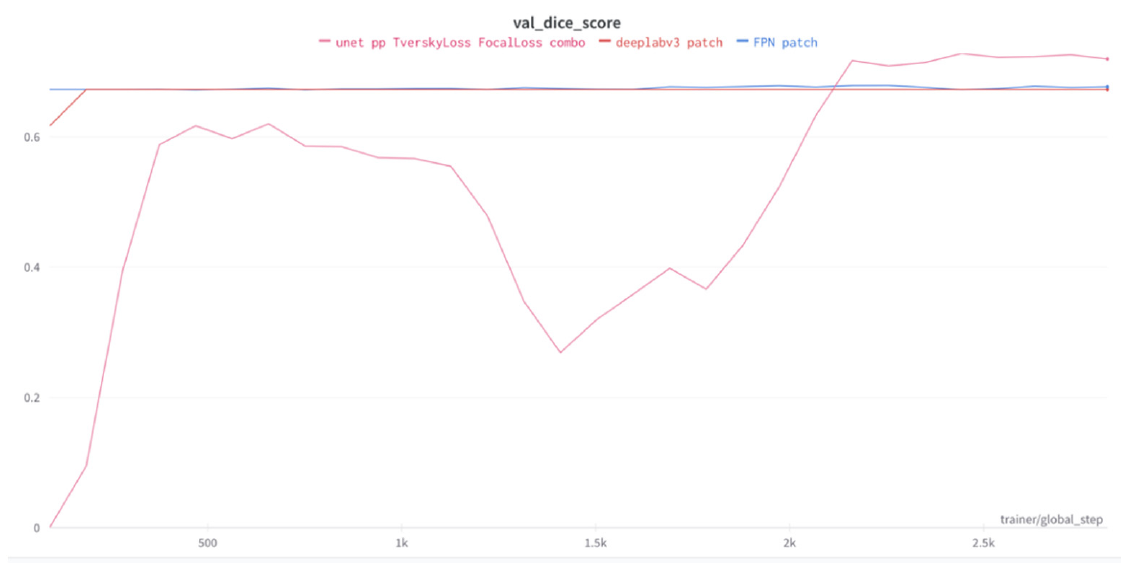
Figure 20. Training log (proposed method, DeepLabV3 and FPN).